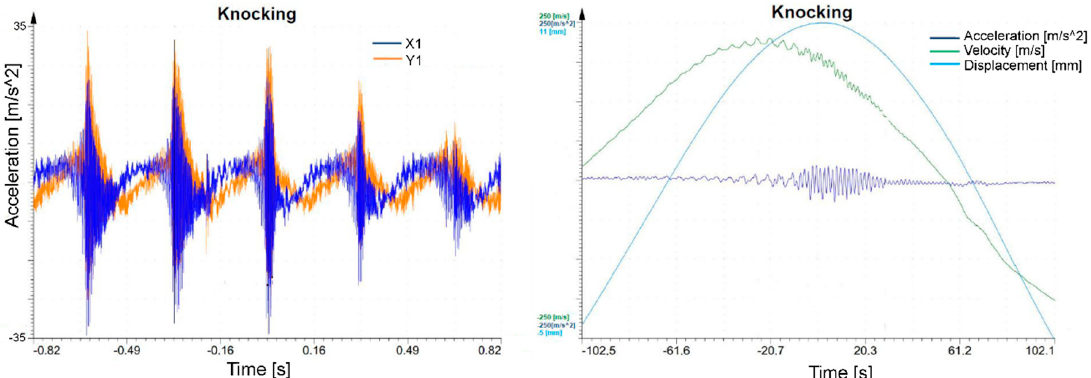
Figure 19. Knocking phenomena in decoupler. On the left, accelerations in X1 (blue) and in Y1 (orange) are shown; beats appears at the same time. On the right, maximum vibration magnitude (blue line) is reached in correspondence of highest displacement (light blue), in green X1